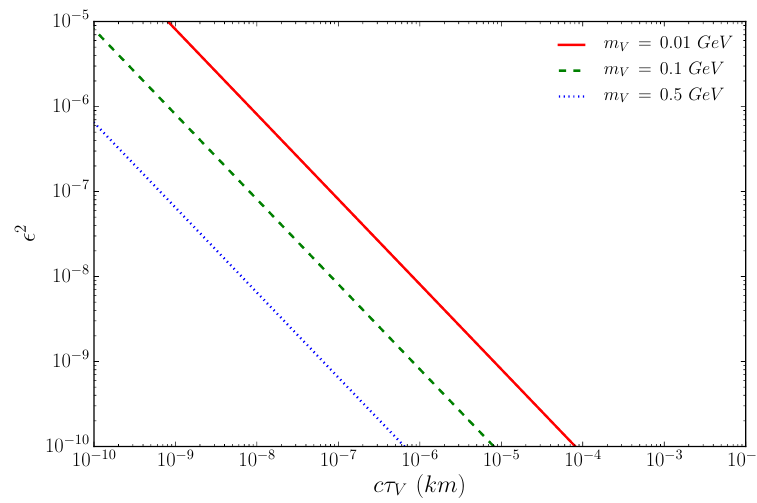
Figure 9 . Correlation between the value of (cid:15) and the lifetime of the dark photon in its rest frame, c(cid:28) V , for three values of m V : 0.01 GeV (solid), 0.1 GeV (dashed) and 0.5 GeV